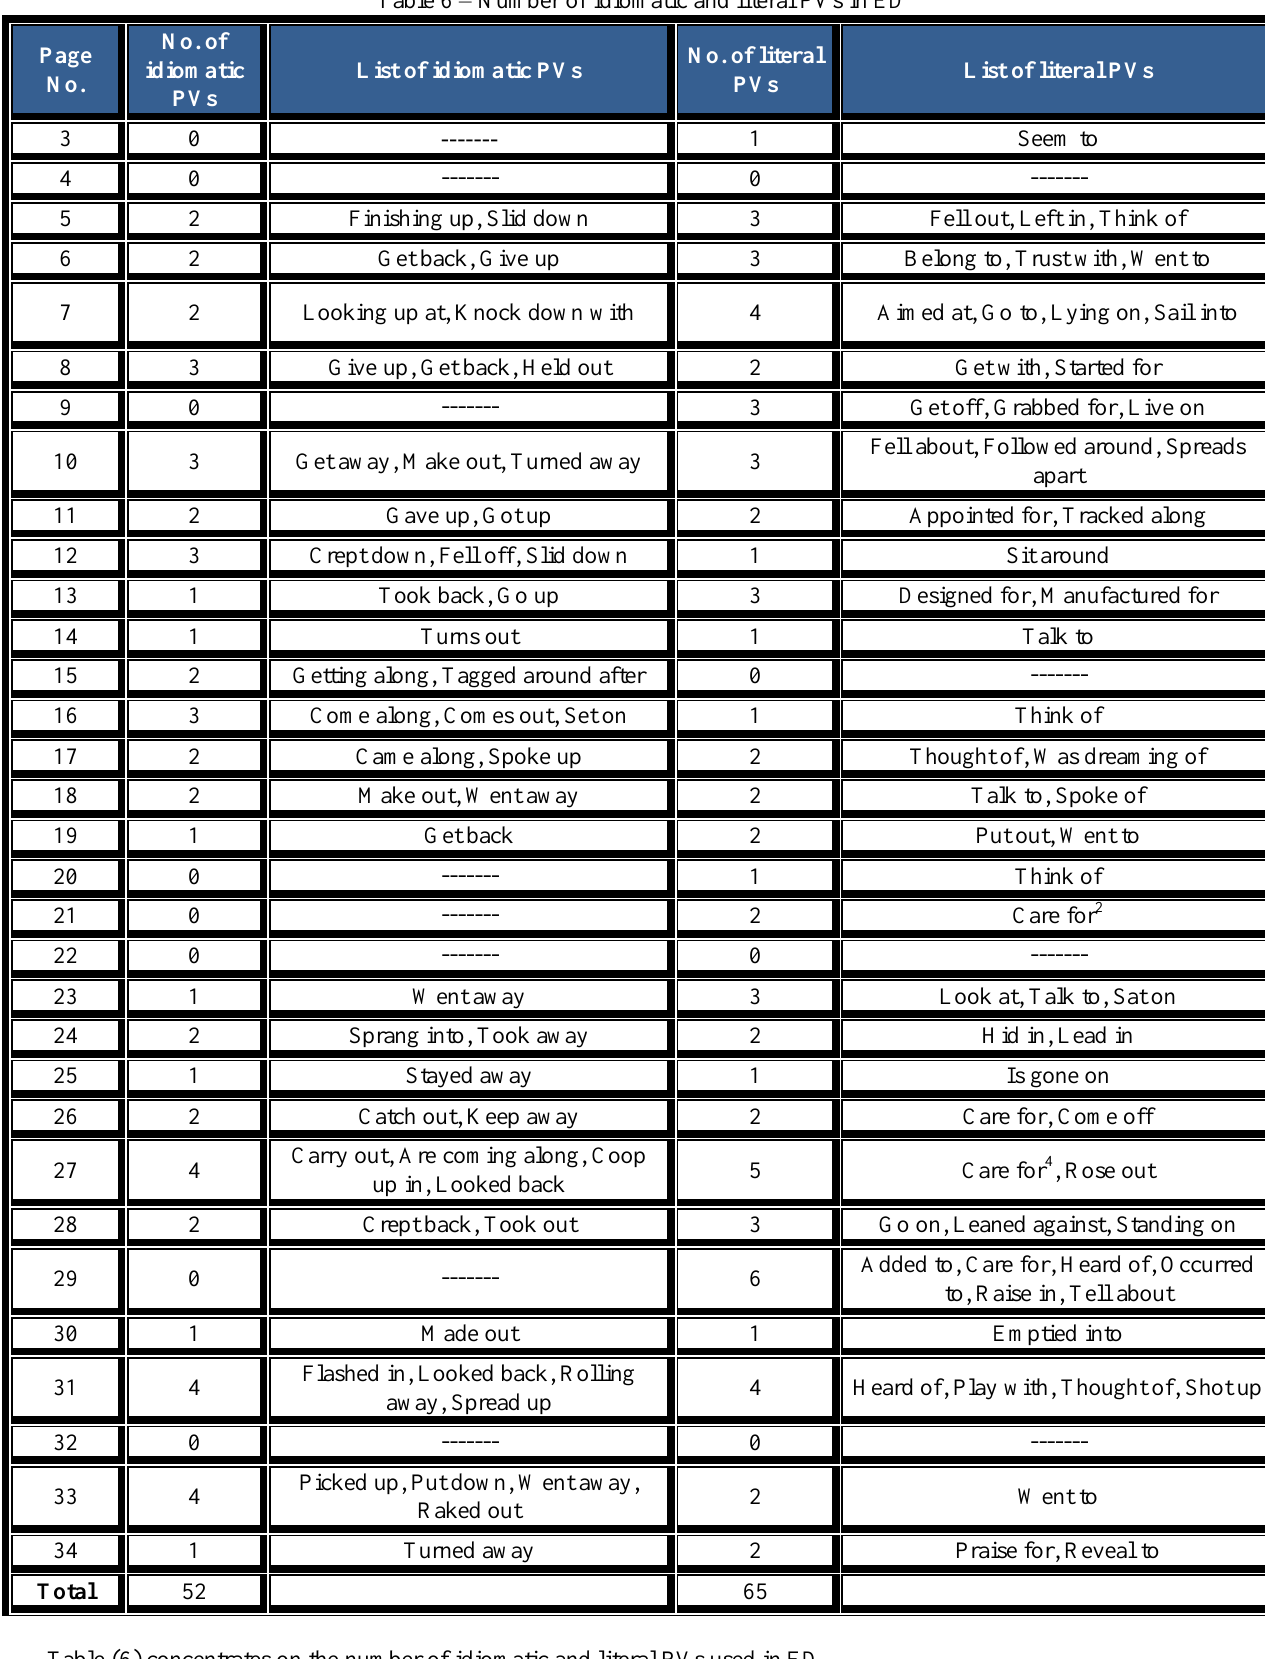
List of literal PVs